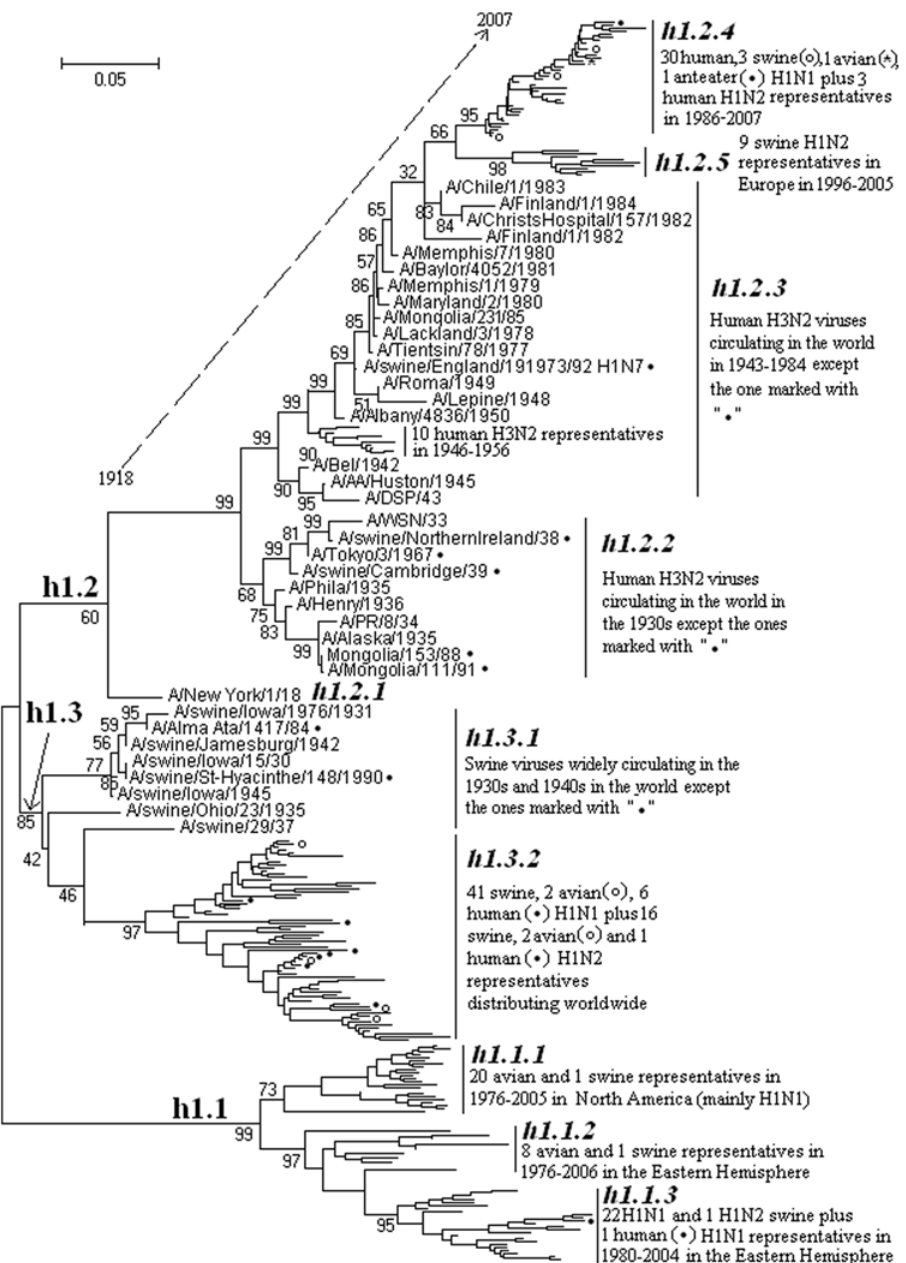
Figure 3. The panorama phylogenetic tree of subtype H1 influenza virus based on the viral HA sequences. The tree suggested that H1 influenza viruses could be divided into 3 lineages largely corresponding to the avian, human and classical swine H1 influenza viruses, respectively. Bootstrap values were given at relevant nodes.